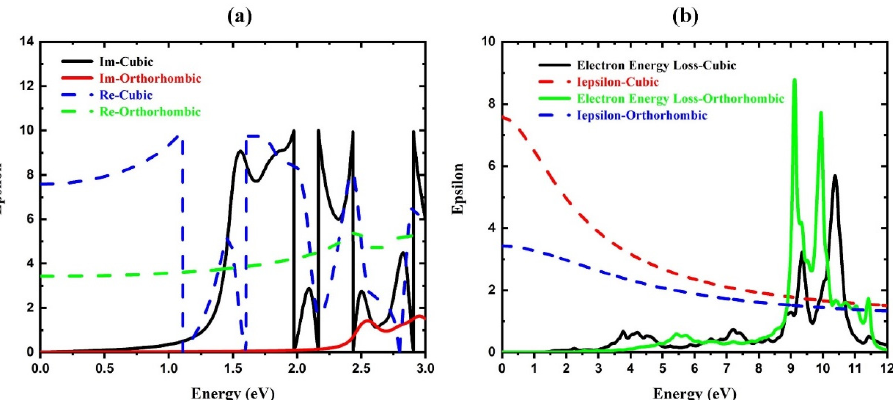
Table 5. Static dielectric constant of CsPbI 3 for the cubic and orthorhombic phases. Perovskite Structures